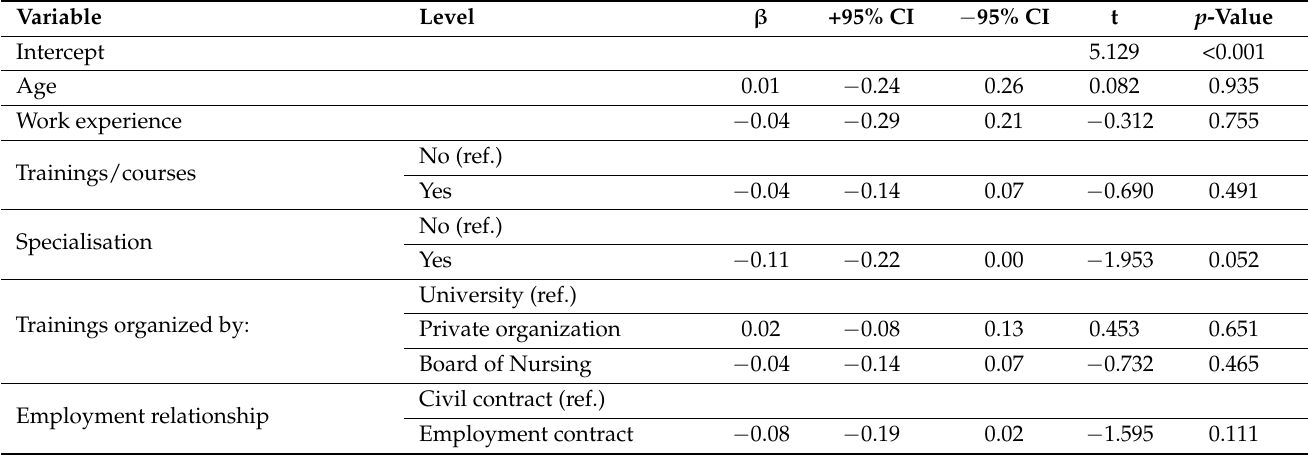
Table 10. Regression analysis for the full multivariate model for the subscale ‘Attitude towards selected aspects of EBNP at